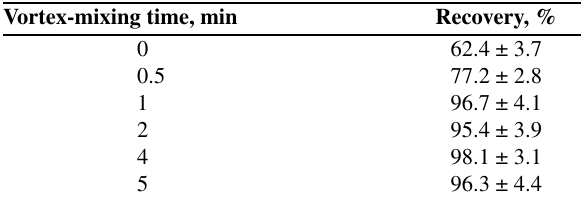
Table 4. Influence of vortex-mixing time on recovery 10 μg L –1 Au(III) ions as ion pair complex (sample volume: 8.0 mL, centrifu-